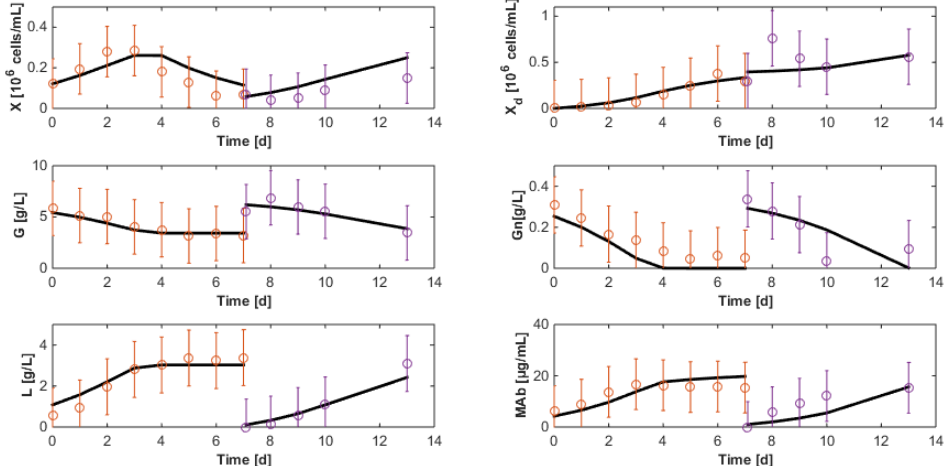
Figure 8. Cross-validation with the second data set of the HB2 strain of the reduced model identified with HB1 data sets. The solid line represents the model while the circles represent the experimental measurements with a confidence interval at 99%.